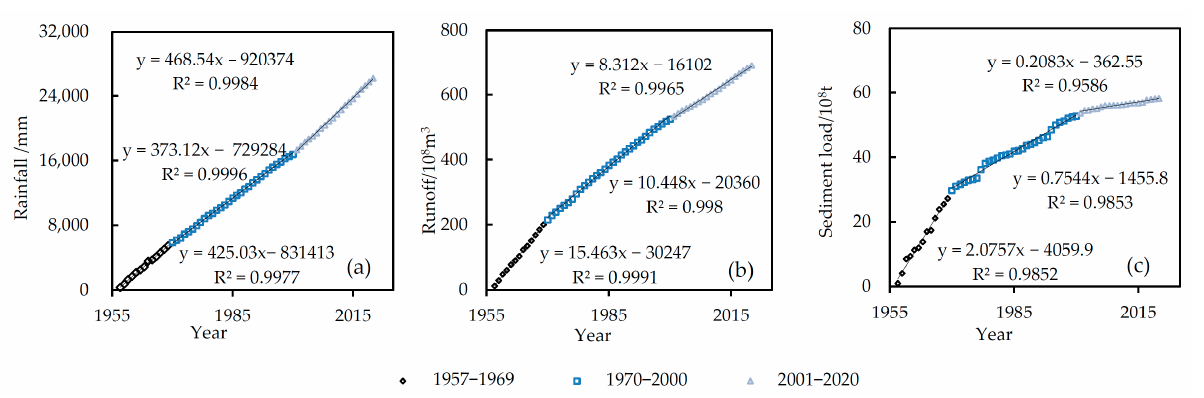
Figure 5. Double cumulative curves of rainfall, runoff, and sediment load over time in the Wuding River basin. ( a ) rainfall over time; ( b ) runoff over time; ( c ) sediment load over time. Table 3. Contribution rate of climate change and human activities in the Wuding River basin during the study period calculated by the cumulative curve